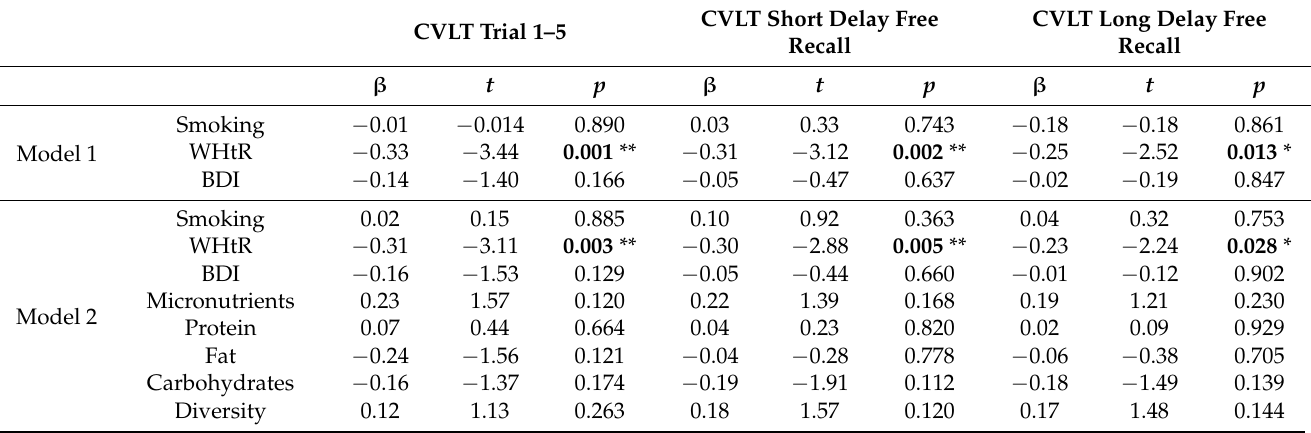
Table 3. Association of nutritional behavior with CVLT parameters.